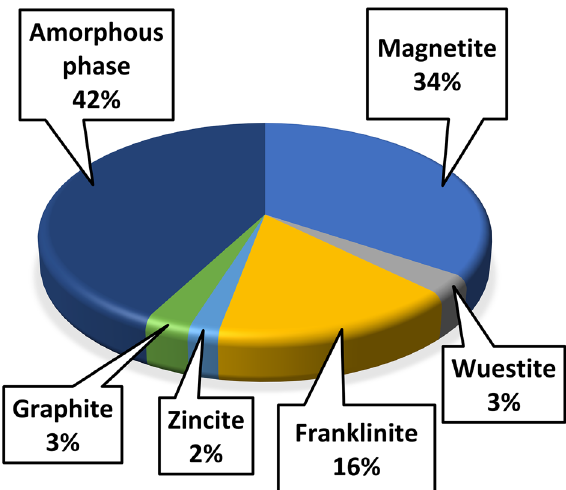
Figure 1. Mineralogical composition of the sludge.